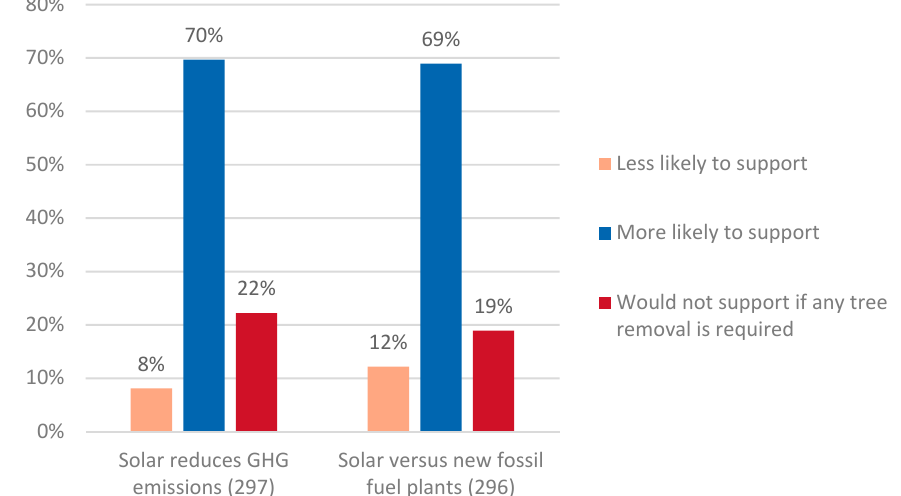
Figure 6. Economic Factors Influencing Support.